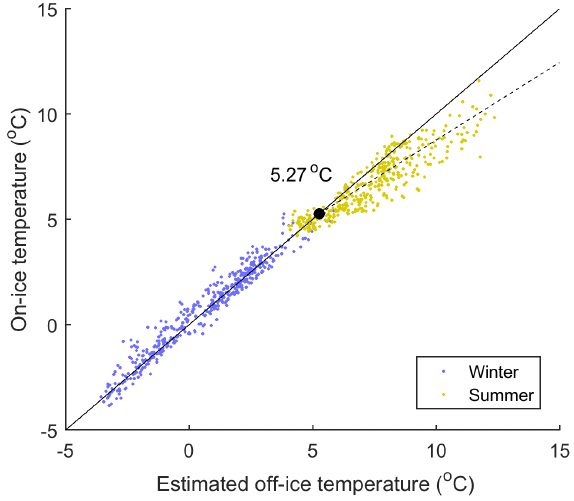
Figure B3. Derived temperature threshold at which on-ice temper- ature is cooler than the ambient off-ice temperature using the Shea and Moore (2010)